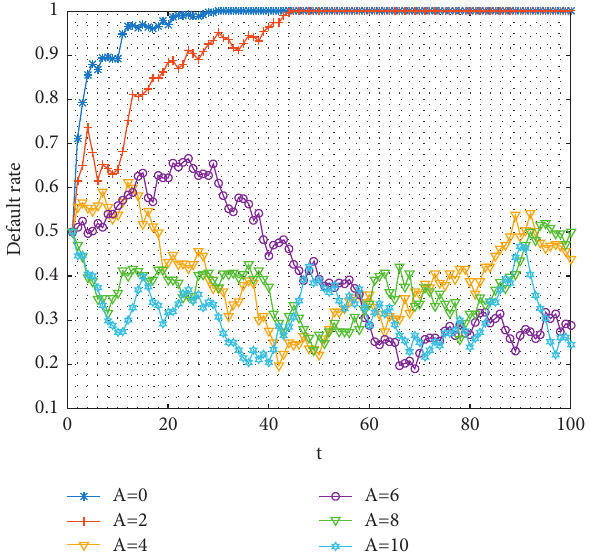
Figure 8: The effect of additional benefits on the spread of default behavior in s scale-free